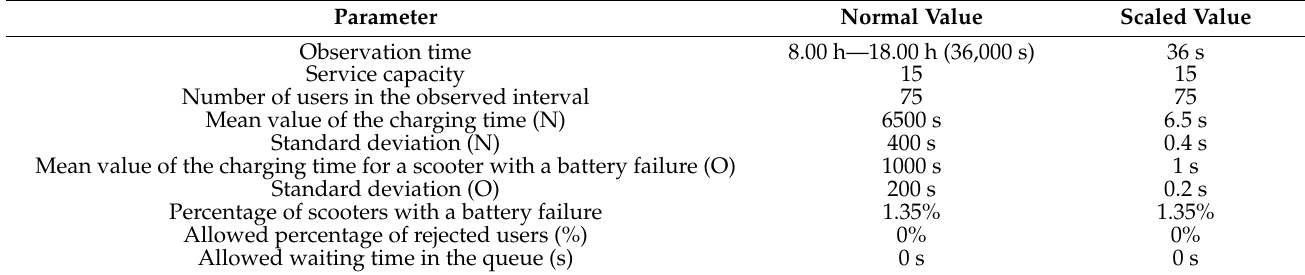
Table 2. Coefficients of polynomials P and Q are used to obtain the normal distribution